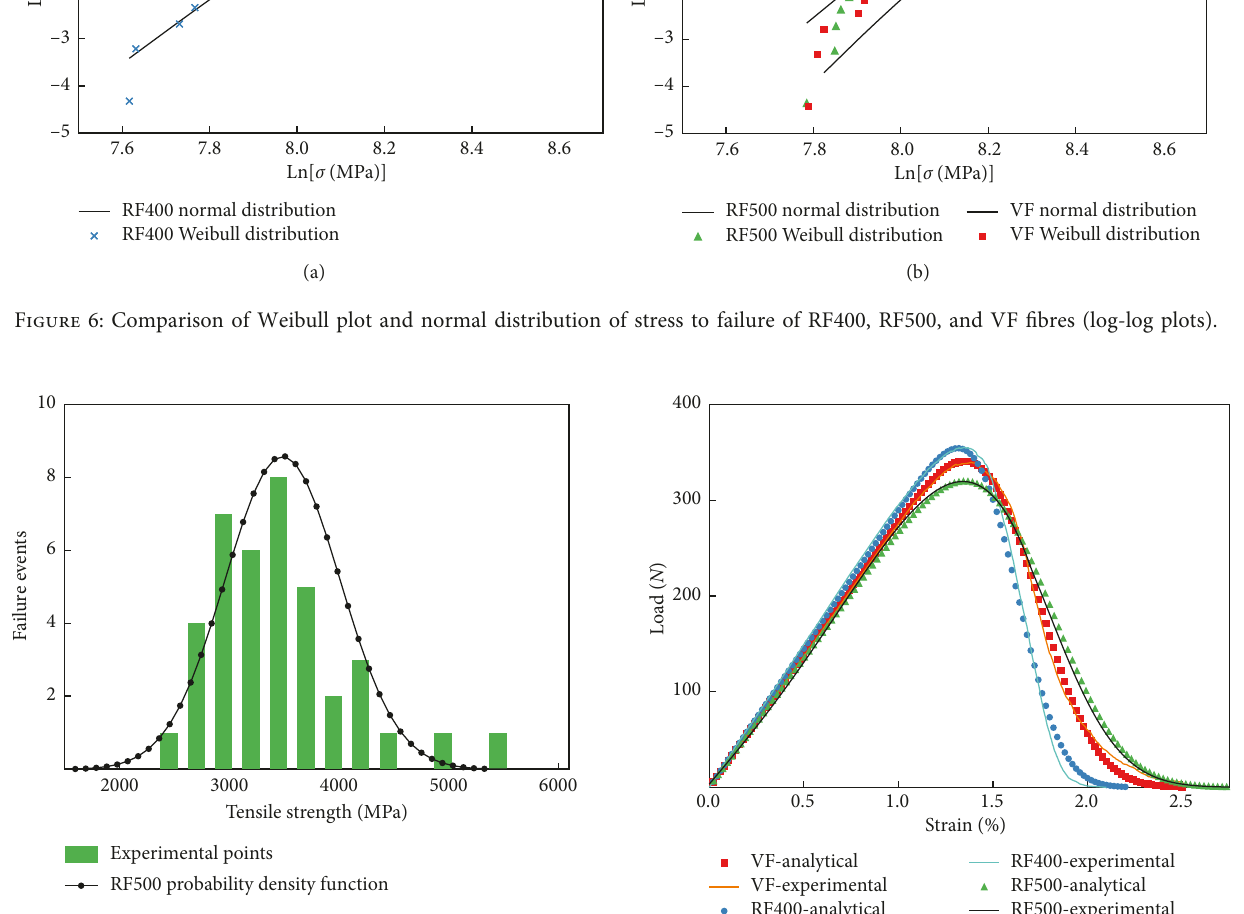
Figure 7: Normal probability density function of RF500 fibre and frequency histogram of failure events. Figure 8: Typical load-strain curves obtained from bundle me- chanical analysis and their fitted analytical